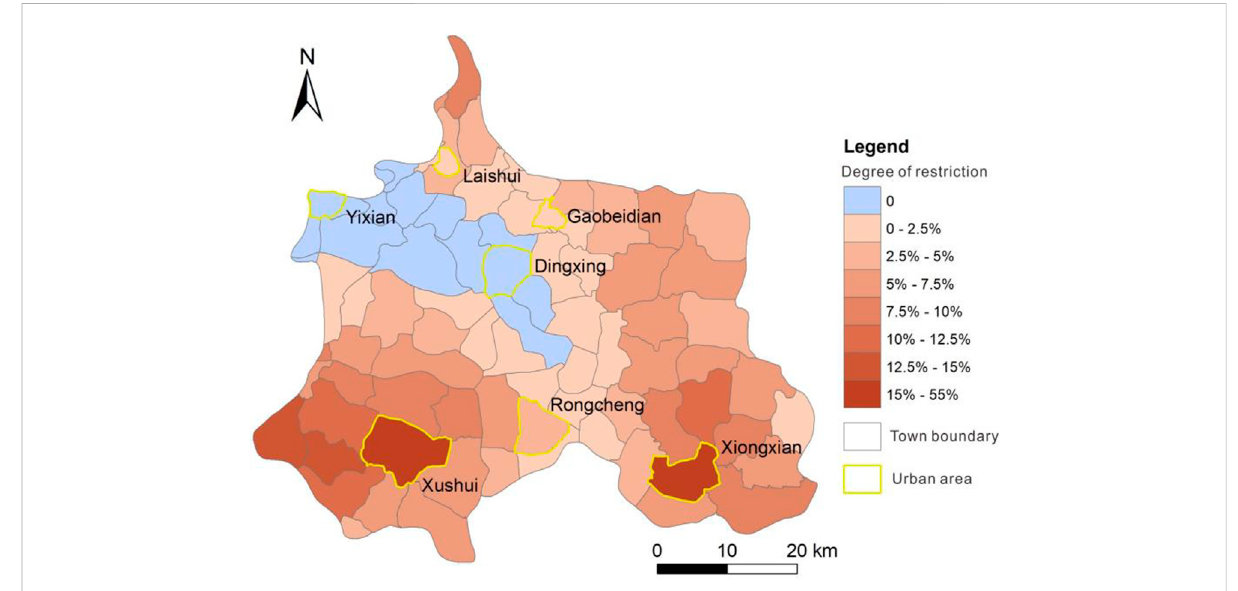
FIGURE 7 Distribution of the degree of groundwater pumping